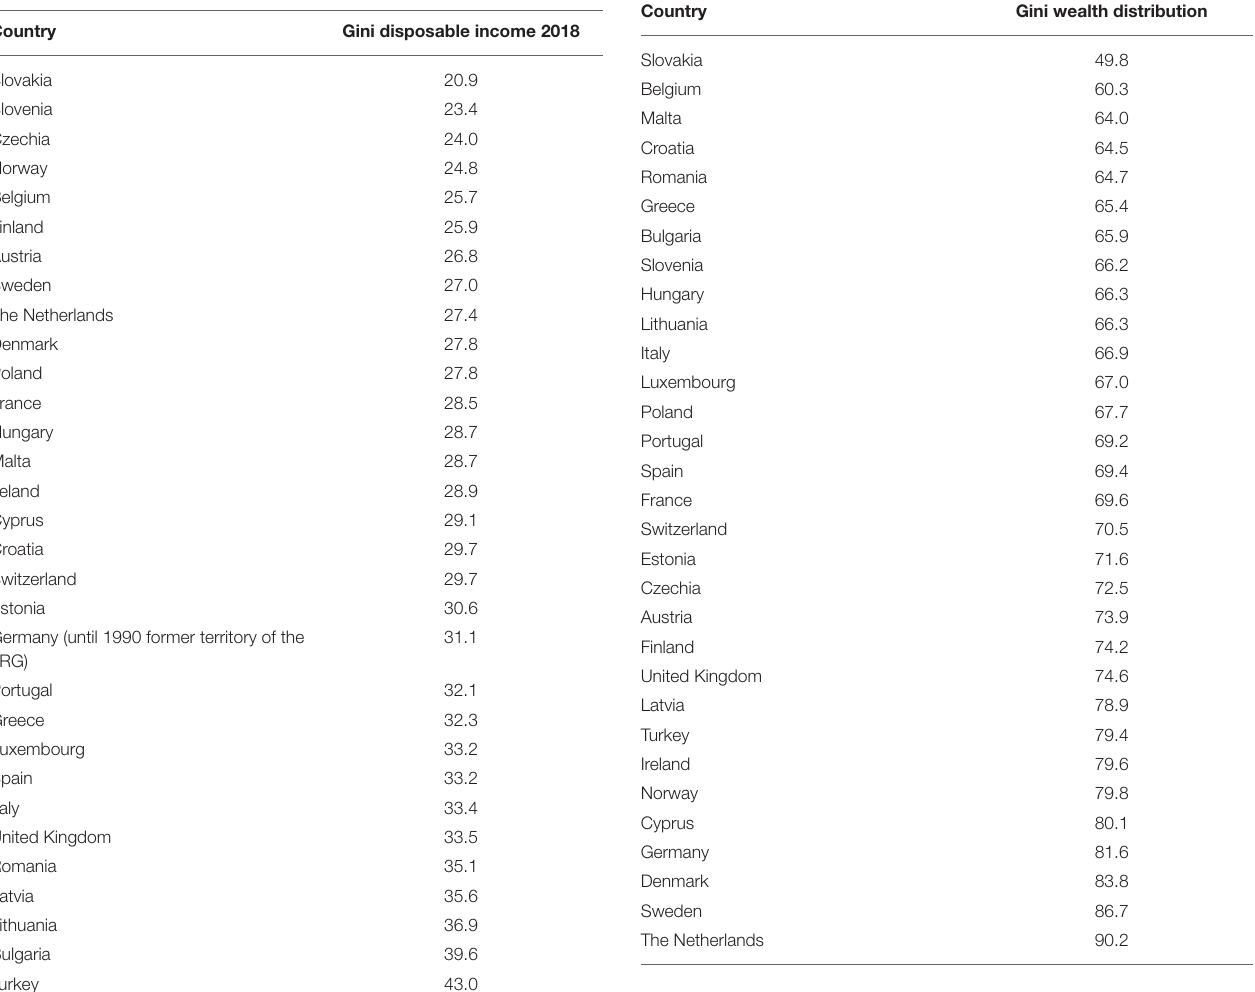
TABLE 1 | Gini coefficient of equivalized disposable income of European countries 2018.